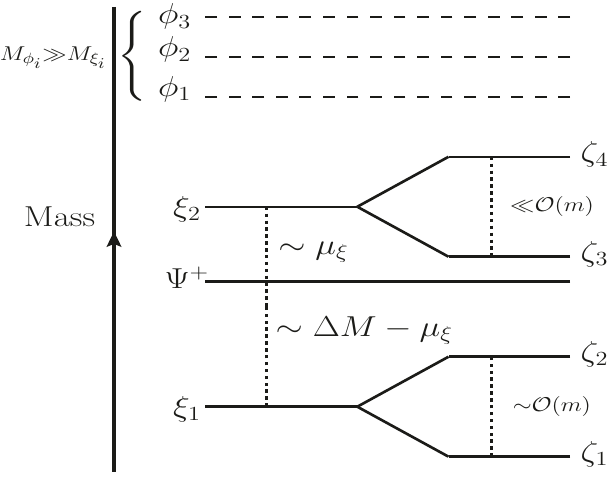
Figure 1 . Mass spectrum of the dark sector, showing the lightest pseudo-Dirac mode as the dark matter and other heavy BSM fermions and scalars. The mass of the charged fermion is M Ψ and it lies somewhere in between ξ 1 and ξ 2 with µ ξ = ∆ M sin 2 (2 θ ) in the limit of small sin θ . The mass 4 ordering is subject to change depending on the numerical values of m , ∆ M and sin θ